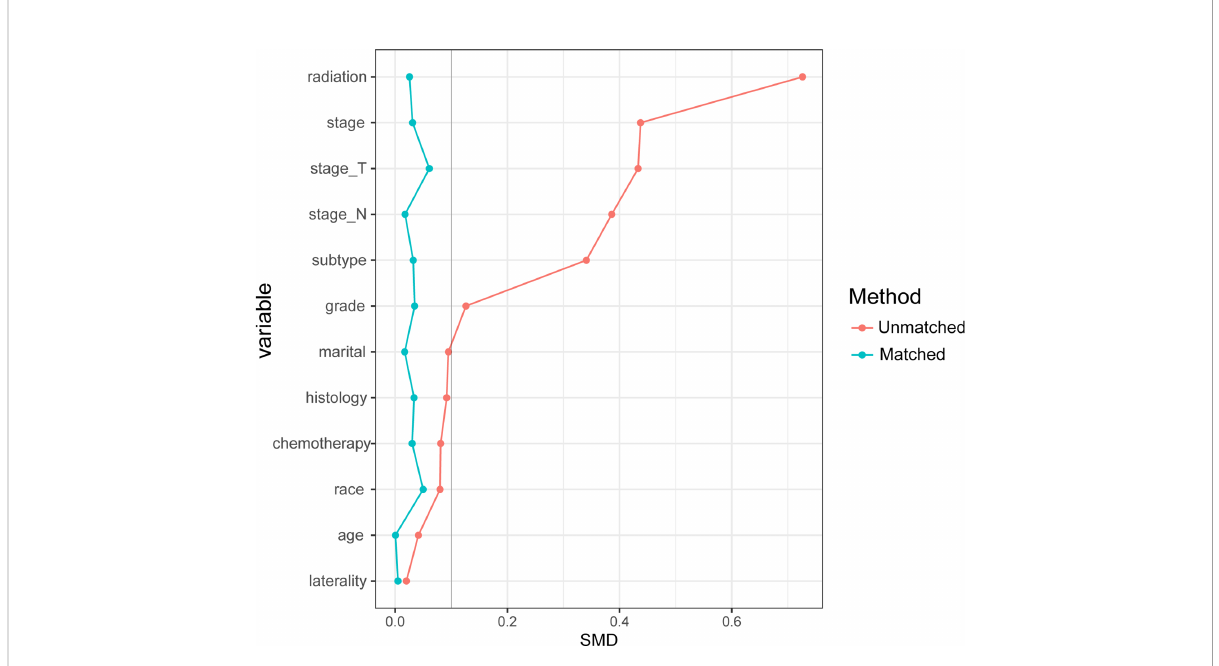
FIGURE 2 The matching effects of the propensity score matching